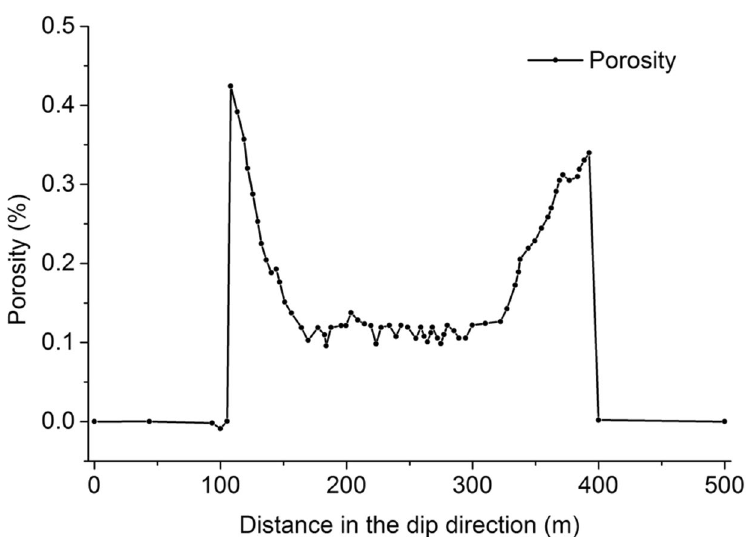
Figure 4. The porosity distribution of the strike caving